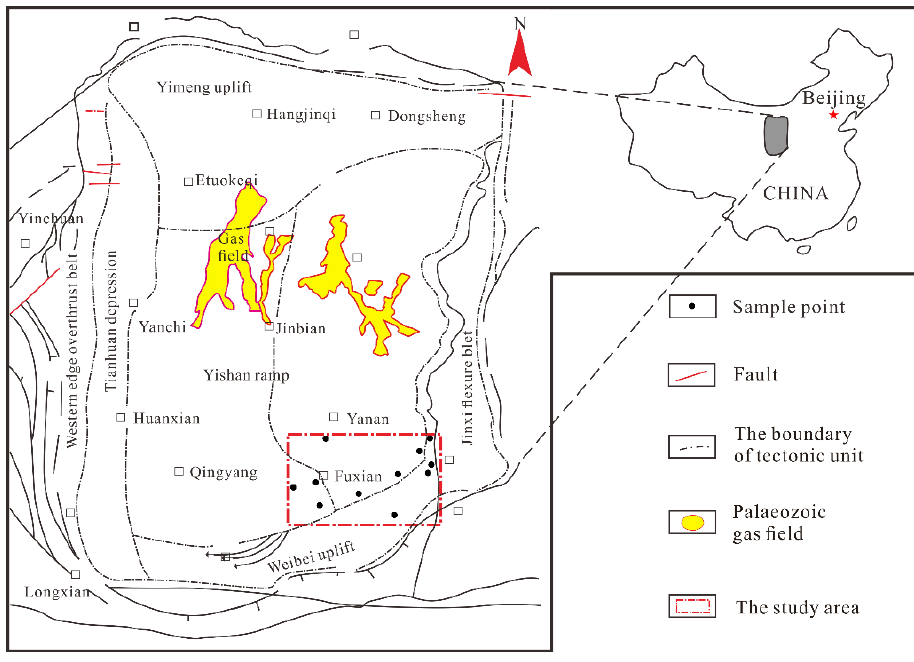
Figure 1. The location map of the study area.